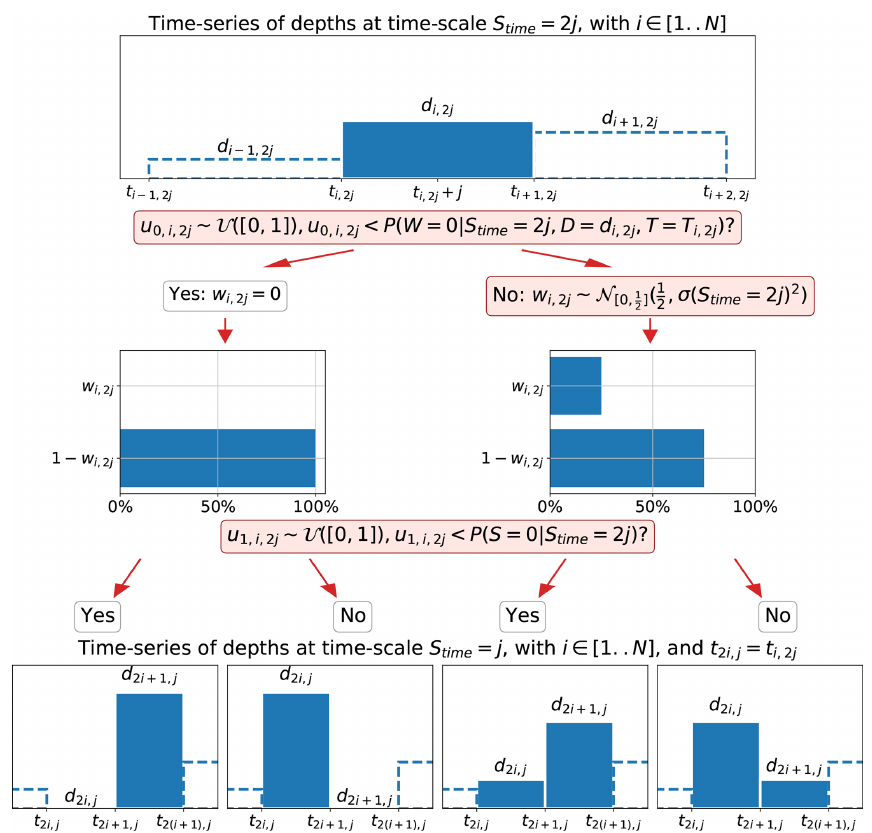
Figure 1. Workflow for downscaling to transfer a depth from time step T to time step T number. The process starts with 1440min time step to reach 5.625min. An interpolation is then done to reach a 6min time step.